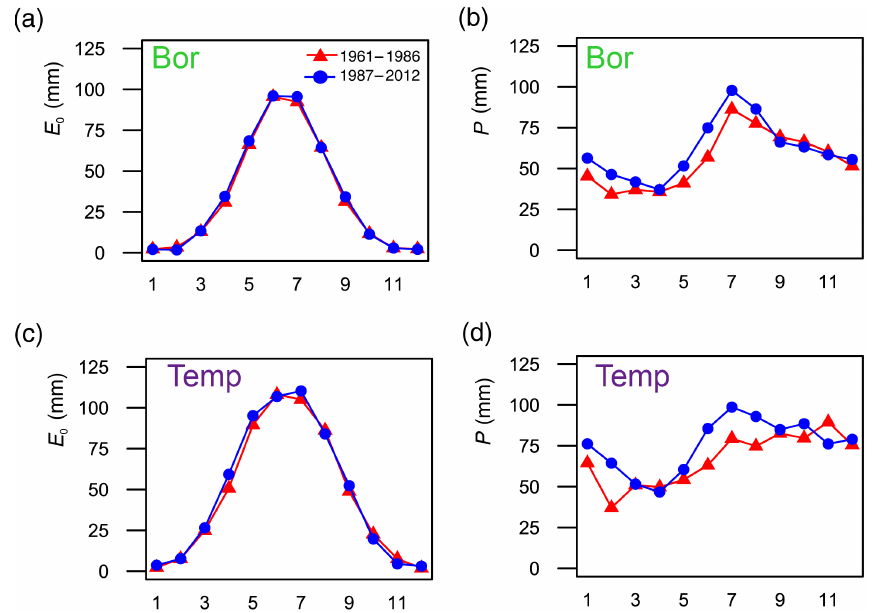
Figure 5. Intra-annual change in precipitation ( P ) and potential evapotranspiration ( E 0 ). Changes in the mean of P and E 0 between the periods 1961–1986 and 1987–2012 in the boreal (a–b) and temperate (c–d) basin groups for each month – January (1) to December (12).